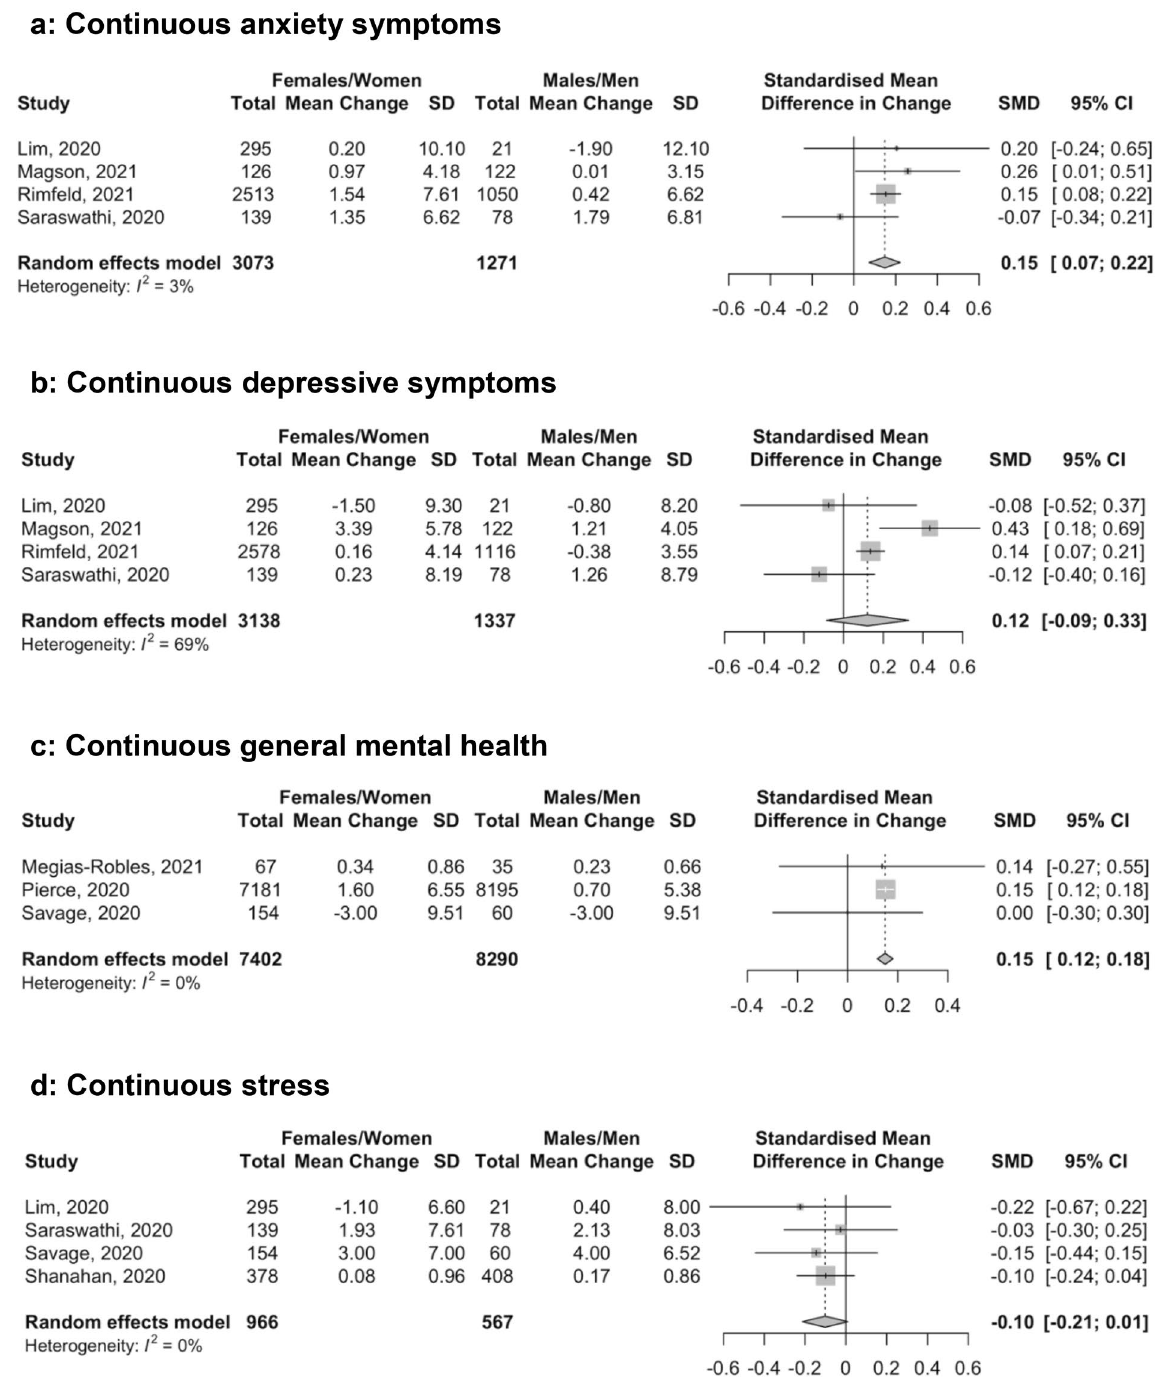
Figure 1. Forest plots of standardized mean difference of the difference in change in continuous anxiety symptom scores ( a ), depression symptom scores ( b ), general mental health scores ( c ), and stress scores ( d ) between females or women and males or men. Positive numbers indicate greater negative change in mental health in females or women compared to males or